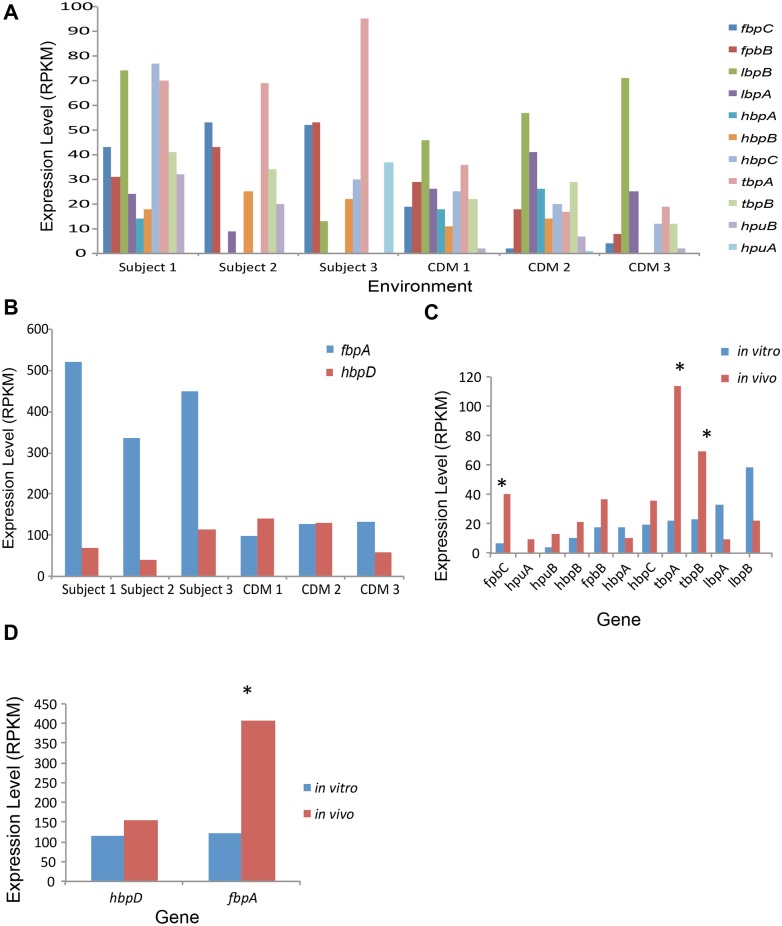
Expression of Gonococcal fbp and tbp genes.
(A) Expression levels of fbpC, (blue) fbpB (red), lbpB (green), lbpA (purple), hbpA (cyan), hbpB (orange), hbpC (light blue), tbpA (pink), tbpB (light green), hpuB (light purple), and hpuA (teal) genes in RNA isolated from individual cervico-lavage samples compared to RNA isolated from the corresponding infecting N. gonorrhoeae strains grown in vitro in CDM supplemented with ferric nitrate (100 μM final concentration). (B) Expression levels of fbpA (blue) and hpbD (red) genes in RNA isolated from individual cervico-lavage samples compared to RNA isolated from the corresponding infecting N. gonorrhoeae strains grown in vitro in CDM supplemented with ferric nitrate (100 μM final concentration). These genes were expressed at significantly higher levels and were placed in a separate graph for ease of viewing. (C) Average expression levels of fbpC, fbpB, lbpB, lbpA, hbpA, hbpB, hbpC, tbpA, tbpB, hpuB, and hpuA gene expression in RNA isolated from 4 cervico-lavage samples (red bars) and average expression levels from the 3 isolated N. gonorrhoeae strains grown in vitro in CDM supplemented with ferric nitrate (100 μM final concentration) (blue bars). Expression levels (RPKM) are shown on the x-axis and represent averages of all cervico-vaginal lavage samples or all isolated strains grown in CDM. * Indicates a q-value of < 0.0001. (D) Average expression levels of fbpA and hpbD gene expression combined in RNA isolated from 4 cervico-lavage samples (red bars) and average expression levels from the 3 isolated N. gonorrhoeae strains grown in vitro in CDM supplemented with ferric nitrate (100 μM final concentration) (blue bars). Expression levels (RPKM) are shown on the x-axis and represent averages of all cervico-vaginal lavage samples or all isolated strains grown in CDM. * Indicates a q-value of < 0.0001.